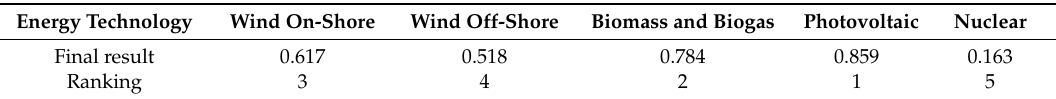
Table 9. Ranking of low-emission energy technologies on the basis of the FAHP method with the use of TOPSIS.